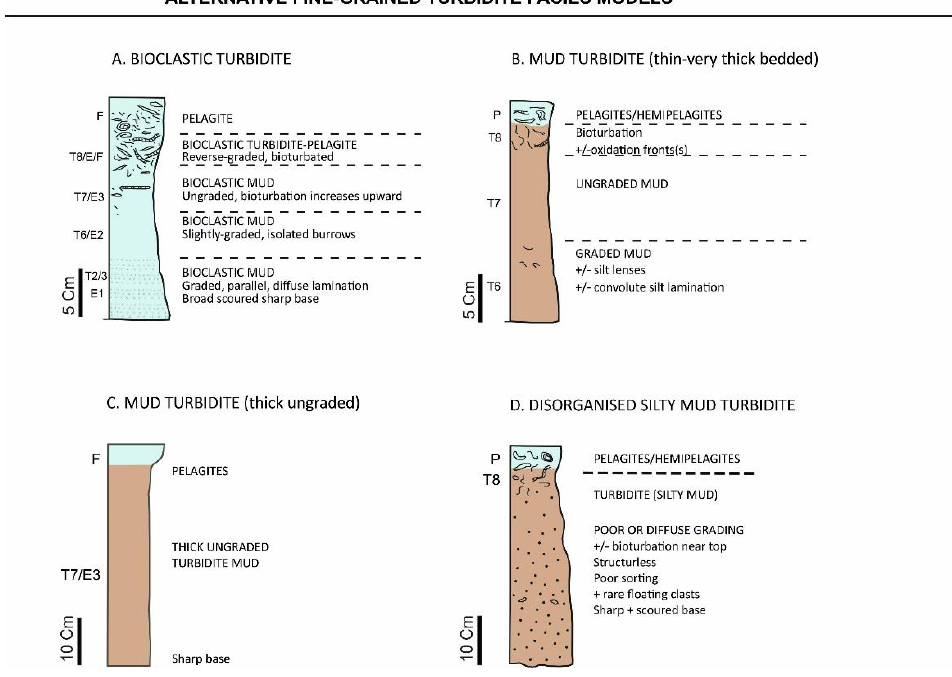
Figure 11. Alternative fine-grained turbidite facies models.